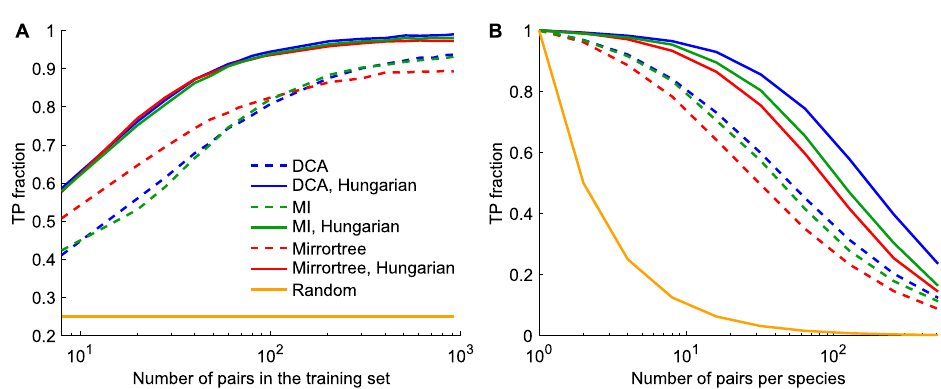
Fig 3. Performance of pairing prediction versus training set size and number of pairs per species. A : Fraction of pairs correctly identified (TP fraction) versus training set size, for DCA-, MI-, and Mirrortree-based methods. The three pairing scores corresponding to each of these three methods are employed in two ways: either within each species we find the chain B with optimal pairing score with each chain A (dashed lines), or within each species we employ the Hungarian matching algorithm to find the one-to-one pairing of chains A and B that optimizes the sum of the pairing scores (solid lines). Each species comprises 4 chains AB. B : Fraction of pairs correctly identified (TP fraction) versus number of pairs per species, employing the same methods (and same colors) as in panel A, and a training set of 50% of the total dataset. In both panels, data was generated using a tree of 10 generations, with exactly 5 mutations per branch, out of 200 bits in each chain AB, thus yielding 1024 chains AB. Species were built randomly, and some of them were chosen randomly to build the training set, the remaining ones making up the testing set. Yellow curves show the chance expectation, i.e. the average TP fraction obtained for random within-species pairings. Results are averaged over 100 replicates in panel A and 20 replicates in panel B, each corresponding to a different realization of the branching process used for data generation. The standard deviation of the TP fraction is 2-3% for large training sets with 4 chains per species (panel A).